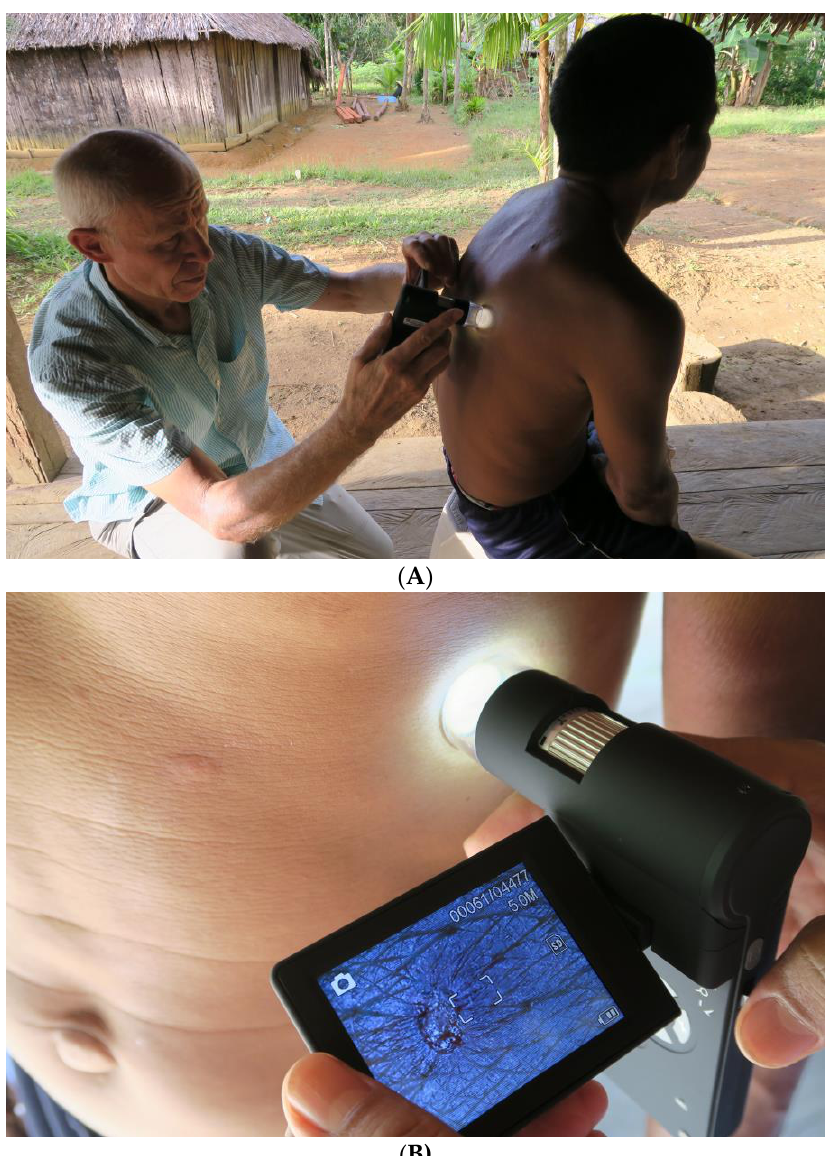
Figure 4. ( A ) Examination of the skin with the digital handheld microscope. ( B ) Examination of the skin with the digital handheld microscope, close-up.